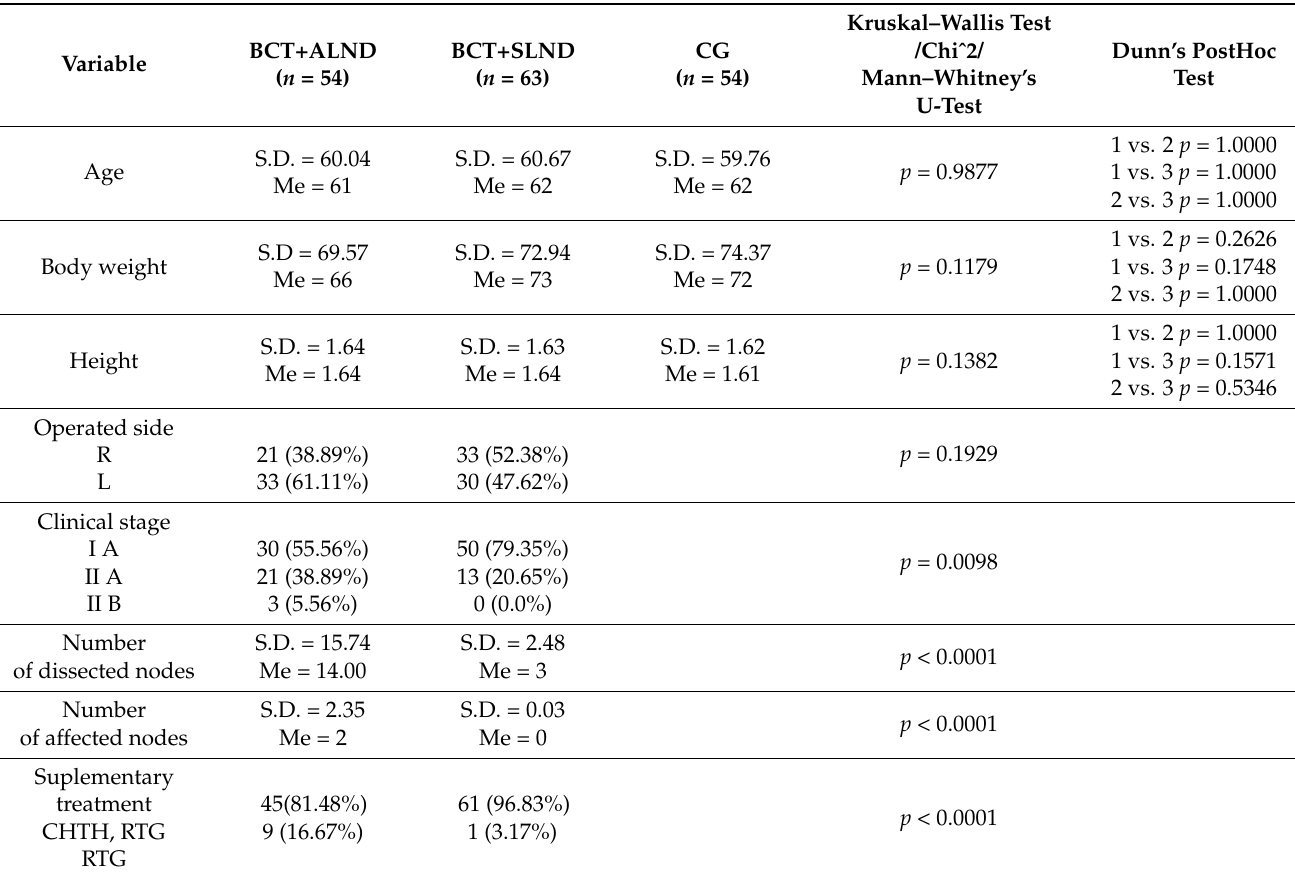
Table 1. Sociodemographic and clinical data in studied